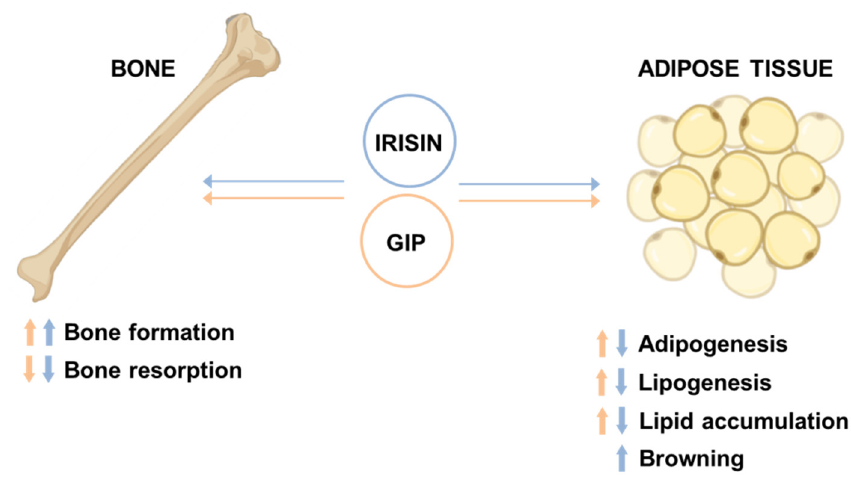
Figure 5. Glucose-dependent insulinotropic polypeptide (GIP) and irisin similarities and differences. Blue arrows indicate irisin effects; orange arrows indicate GIP effects.